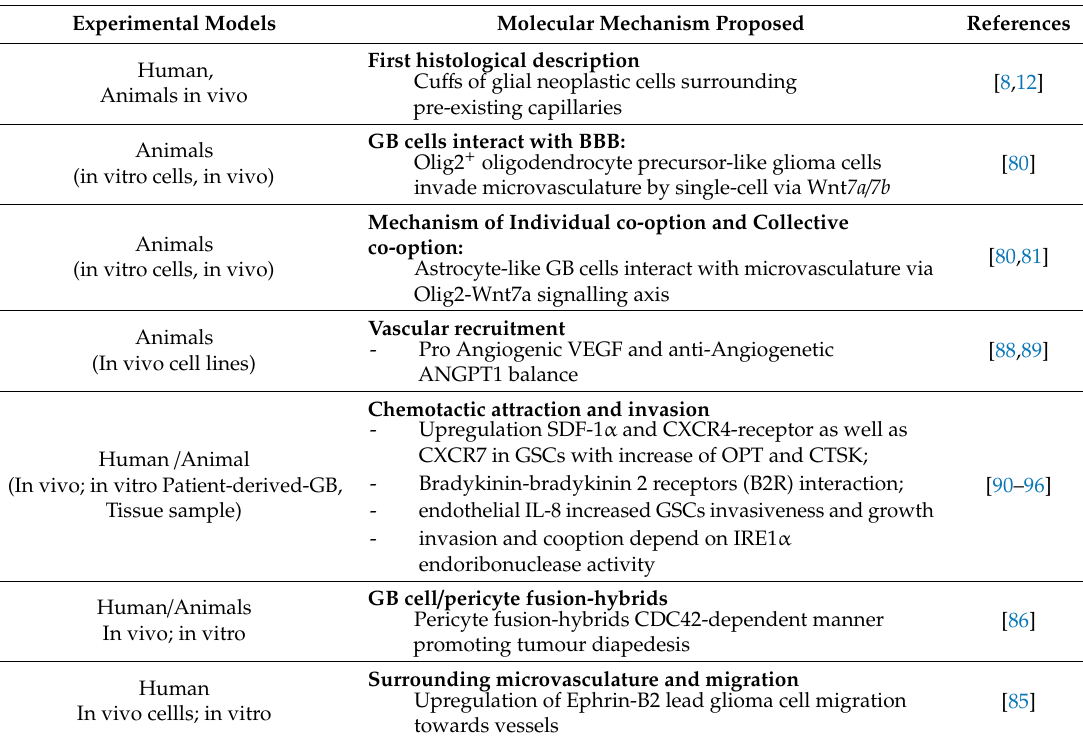
Table 2. Summary of studies investigating the Perivascular Satellitosis process within brain tumour in in vivo and in vitro models along with the molecular mechanism proposed. Bold: is a summary title which encompass di ff erent